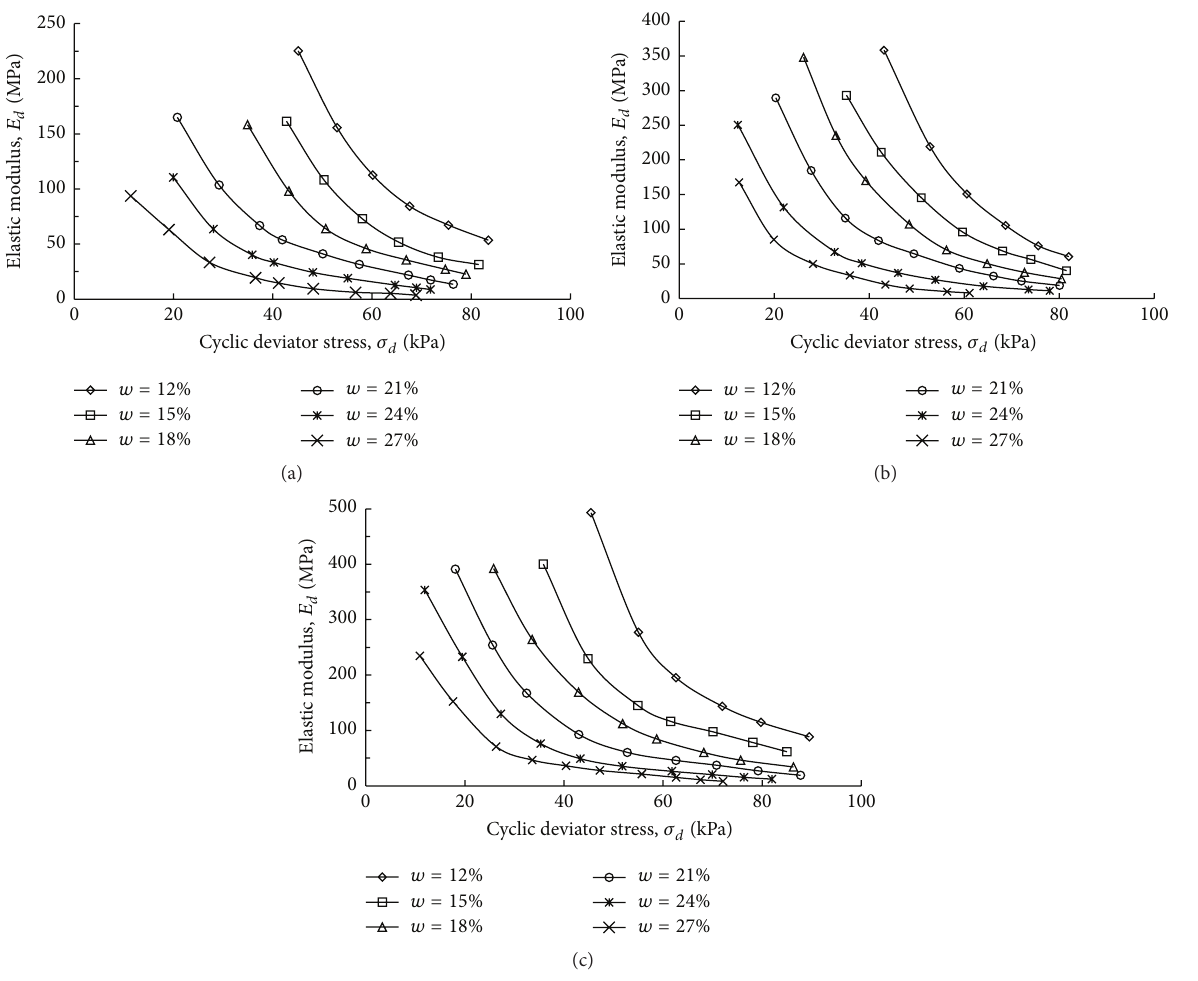
Figure 1: Variation of dynamic elastic modulus with deviator stress at various moisture contents for different degrees of compaction: (a) 𝑘 = 90 %; (b) 𝑘 = 93 %; (c) 𝑘 = 96